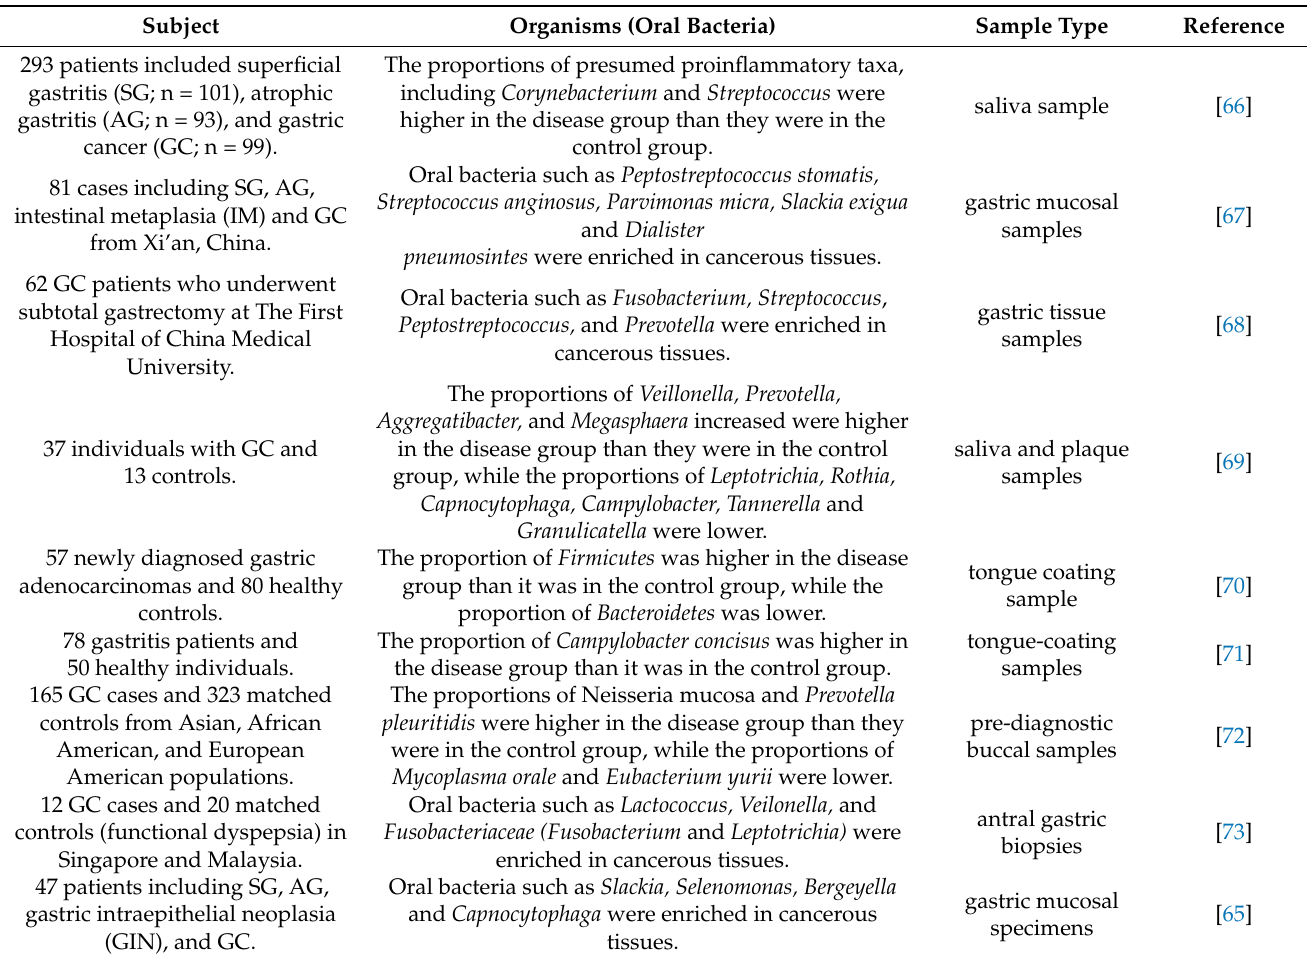
Table 2. Oral organisms associated with gastric cancer